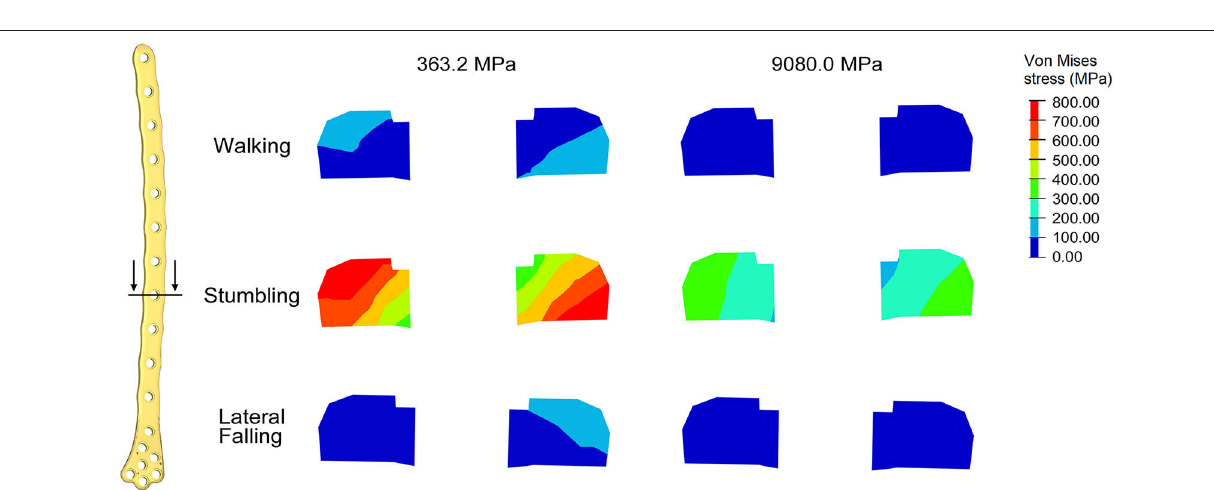
MPa, which settles far below the plate yield point (about